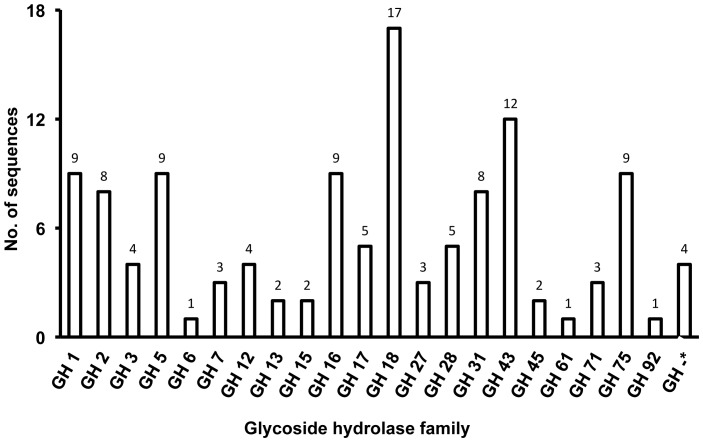
Classifications of putative glycoside hydrolases (GH) from metatranscriptomic information.Uniplot KB (Wu et al., 2006) and CAZy databases (Cantarel et al., 2009) were used to confirm sequence-based similarities of glycoside hydrolases. Stars (*) indicate sequences unclassified in GH families.